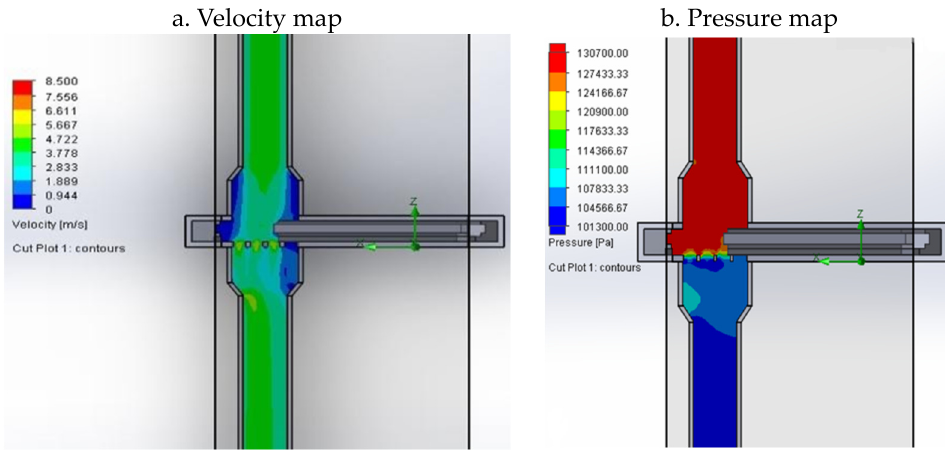
Figure 13. Second valve geometry with 70% opening.